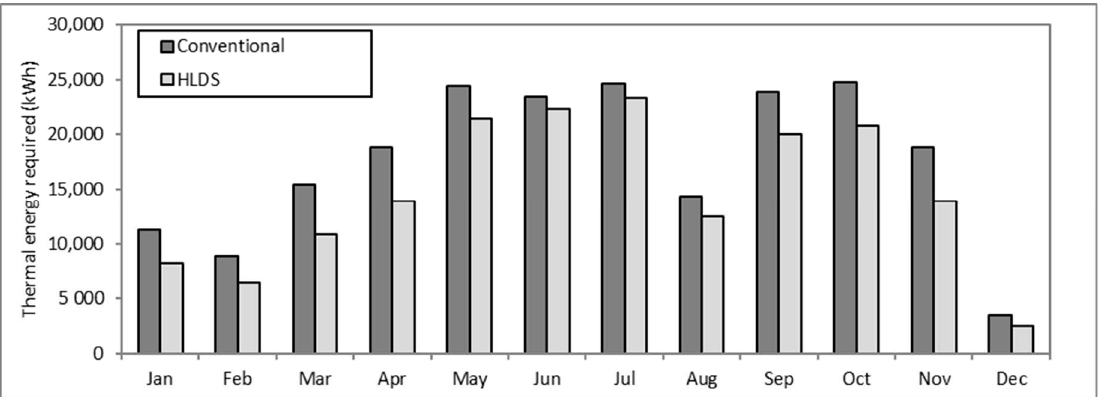
Figure 12. Monthly results of the thermal energy required by a conventional system and the HLDS at optimal working conditions.